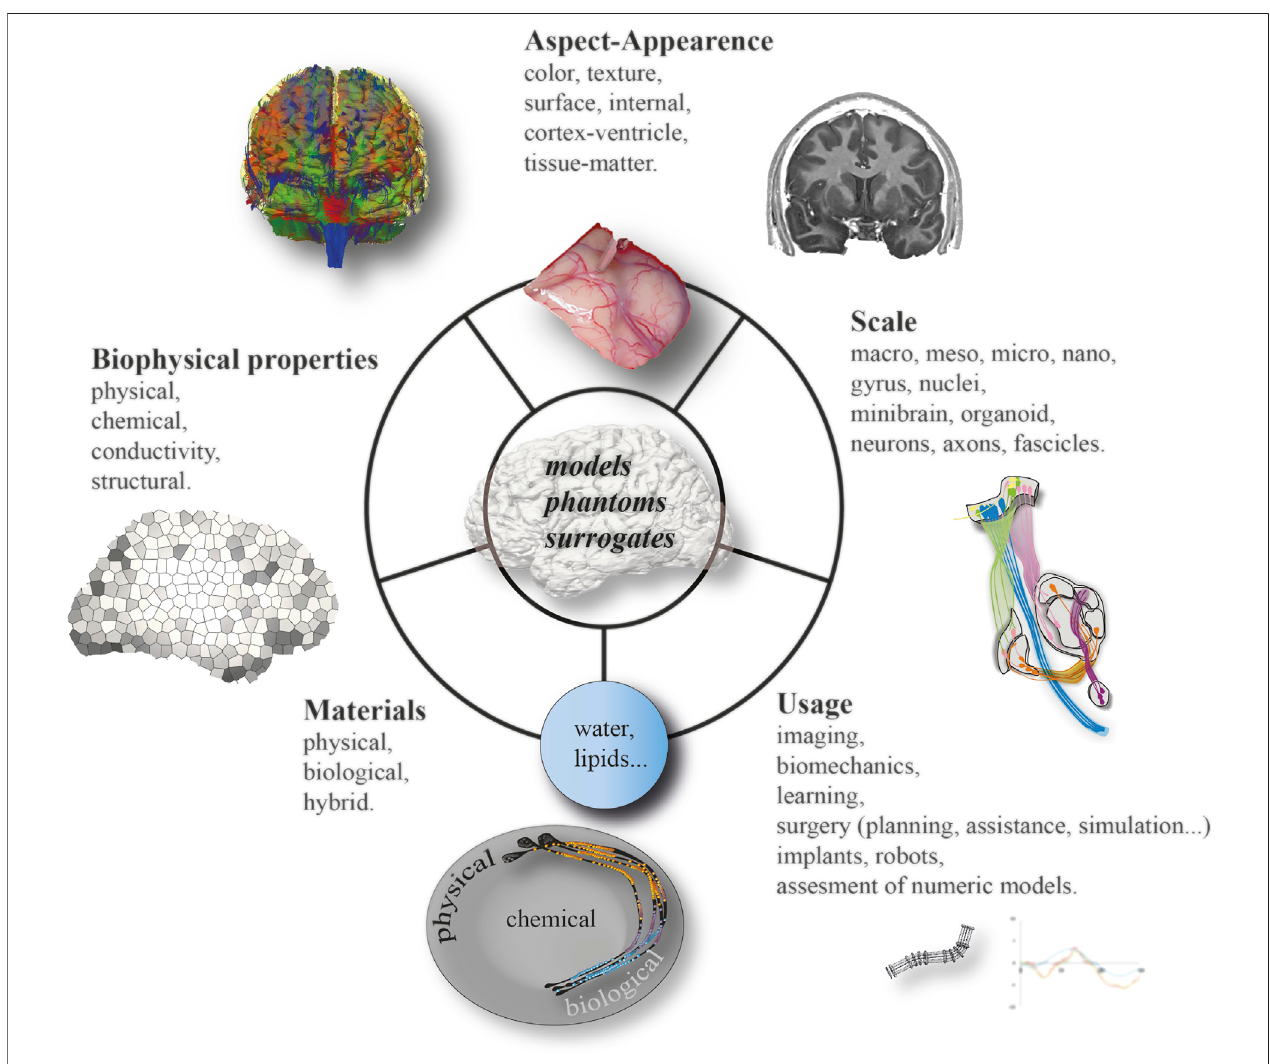
FIGURE 1 | Overview of materials, models, phantoms and surrogates simulating the human brain.